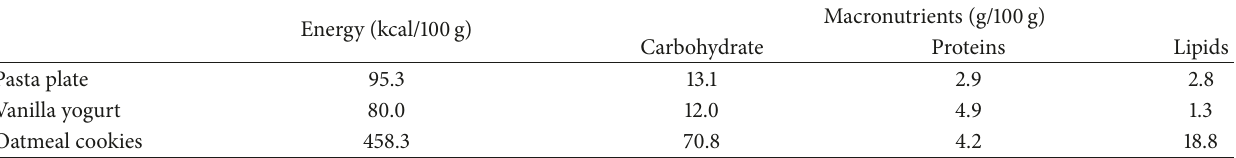
Table 1: Energy and macronutrient composition of the experimental